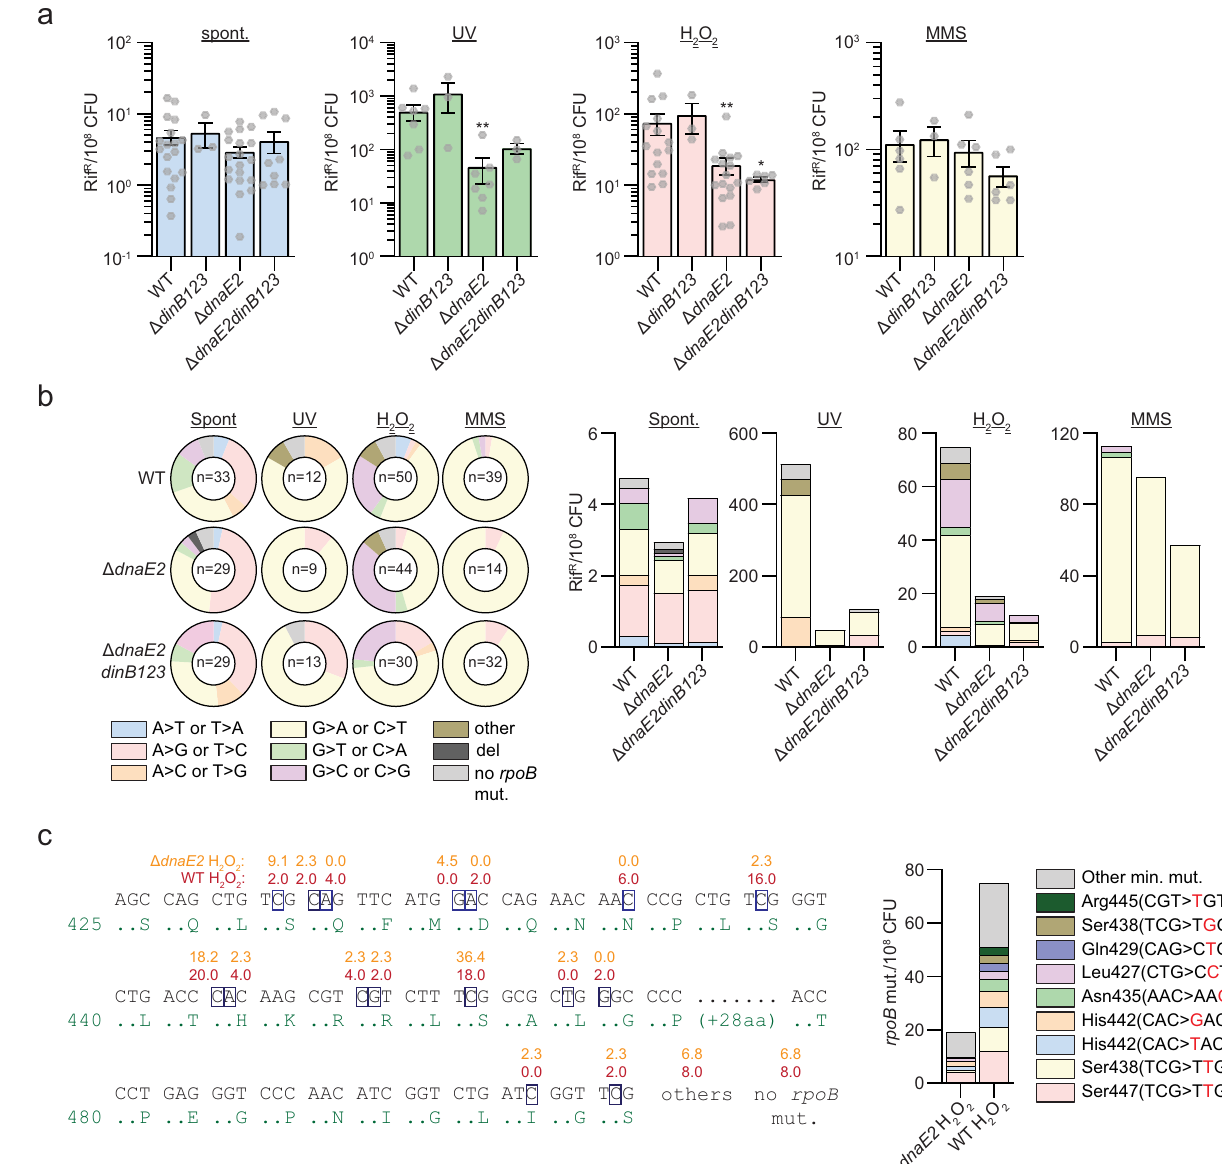
Fig.3|DnaE2butnotDinBsmediatesstress-inducedsubstitutionmutagenesis. a Rifampicin resistance(rif R ) frequencyinindicatedstrains and conditions. Results shownaremeans(±SEM)ofdataobtainedfrombiologicalreplicatessymbolizedby gray dots. Stars above bars mark a statistical difference with the reference strain (WT of each condition) (*, P <0.05; **, P <0.01). p-values were obtained on log- transformed data by one-way ANOVA with a Bonferroni post-test. b Relative